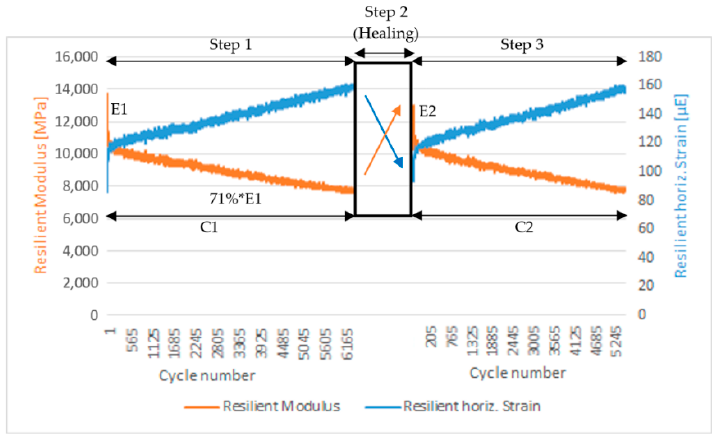
Figure 3. Resilient modulus and resilient horizontal strain of the specimen recorded by the universal testing machine (UTM) during the tests.